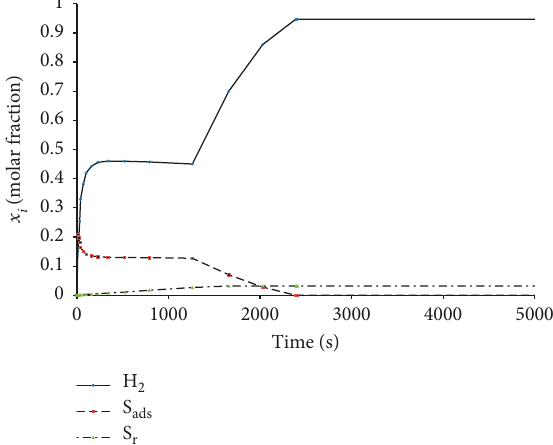
Figure 9: Time evolution of adsorbed species before and after switching feeds with and without S contamination.